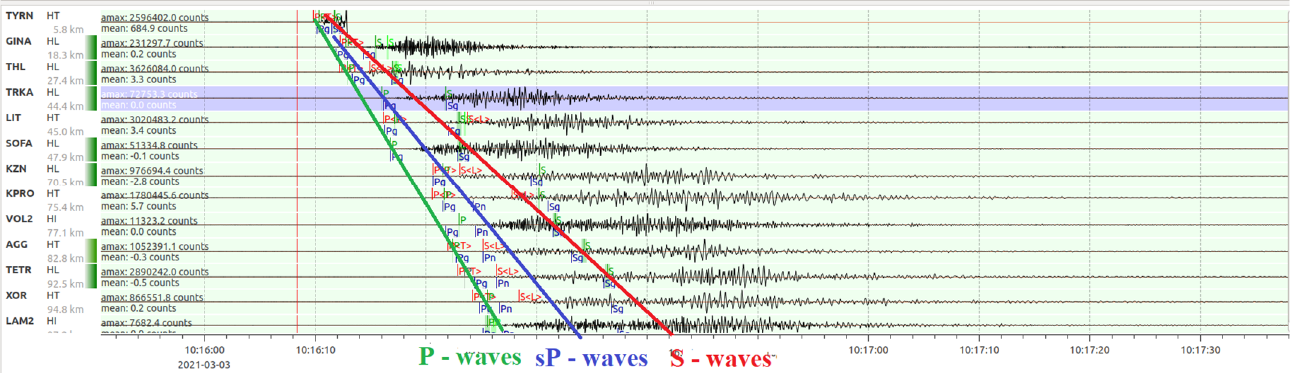
Figure 6. A section of the displacement record of the stations. The horizontal components (east–west and north–south traces) were rotated into radial and transverse components. The sP-wave was clear in the radial and vertical components, but only the S-wave was observed along with the surface waves in the transverse component.